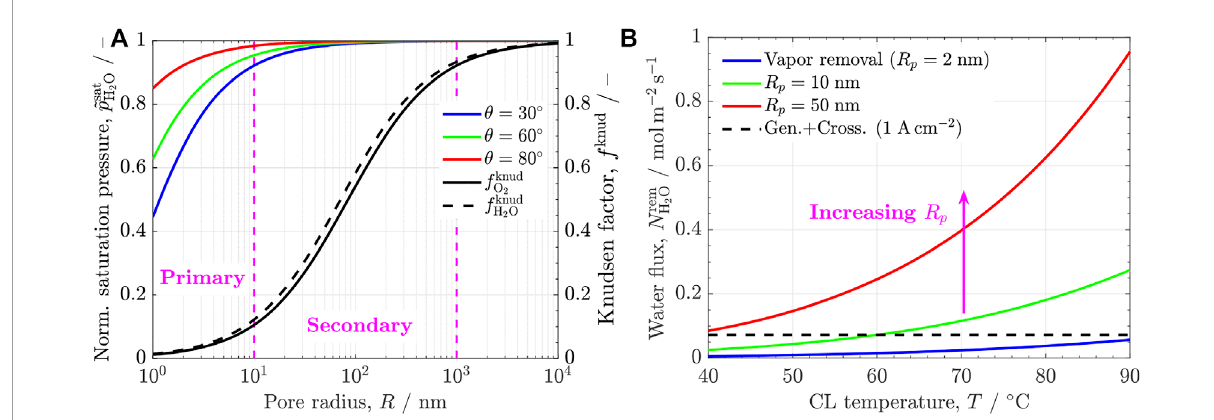
, with the pore radius, R , for three different contact angles, = p H / p sat H 2 O 2 O 2 O